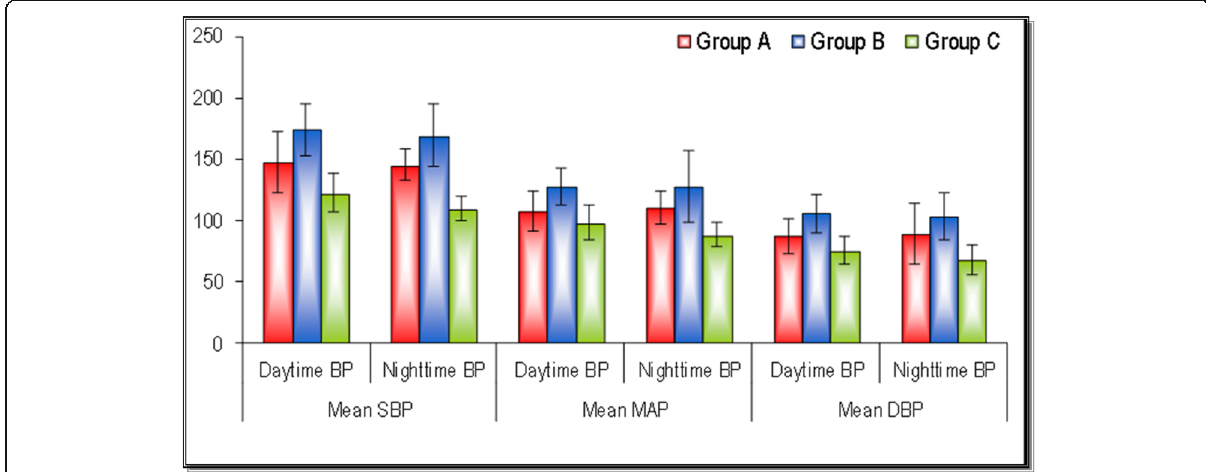
Fig. 2 Difference in 24 h mean blood pressure measurement between patients and control groups